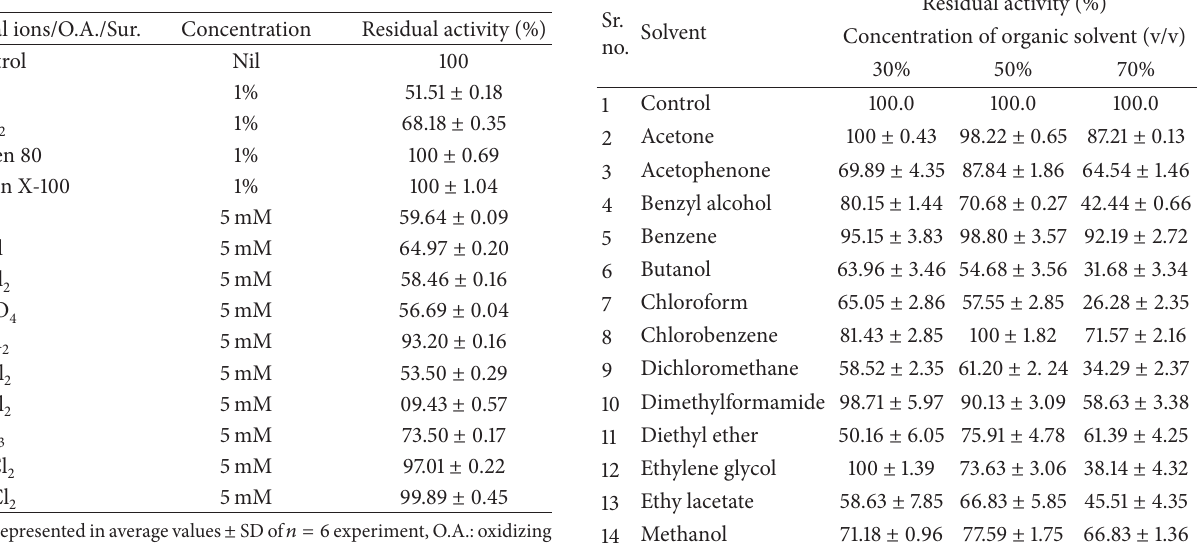
Table 1: Effect of surfactants, oxidizing agent, and metal ions on proteolytic activity.